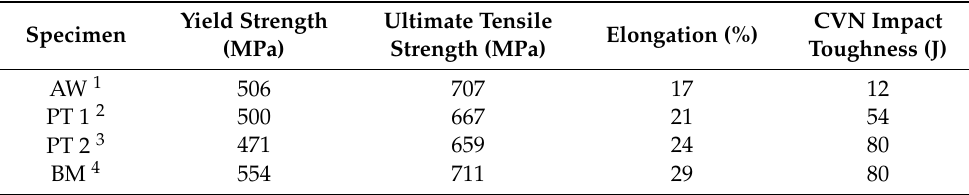
Table 2. Typical mechanical properties of the Gr. 92 cross welds in the as-welded and post-weld tempered